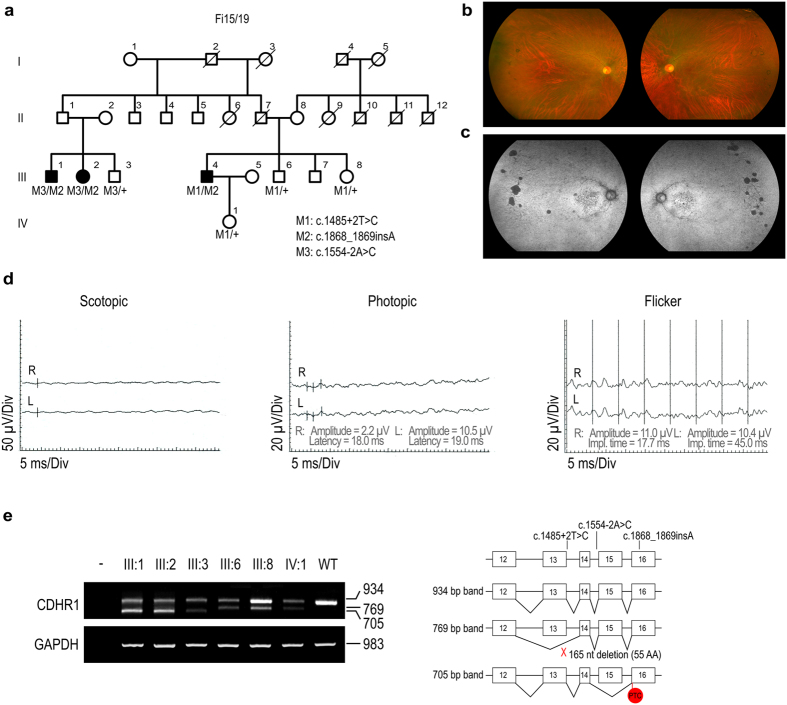
Identification of CDHR1 mutations in a family affected by RP.(a) Cosegregation analysis of CDHR1 variants identified in family Fi15/19. (b and c) Fundus eye photographs and autofluorescence images of the affected member III:2. (d) Electroretinographic recordings under scotopic (0 dB) and photopic (0 dB) conditions from both eyes of patient III:4. A b-wave could be detected in photopic ERG (amplitude and latency values are shown). Photopic 30-Hz flicker (0 dB) was also recorded. (e) RT-PCR analysis of CDHR1 blood mRNA of affected patients (III:1 and III:2), carriers (III:3, III:6, III:8, and IV:1), and one control individual (WT). Patients and carriers showed a dramatic decrease in the CDHR1 normal transcript. III:1, III:2, and III:3, who carry c.1554-2A > C, also produced a lower mass band corresponding to an mRNA that skips exon 15, whereas members III:6, III:8 and IV:1, carriers of c.1485 + 2T > C, presented a 769 bp band that directly links exon 12 and 14 of the gene.